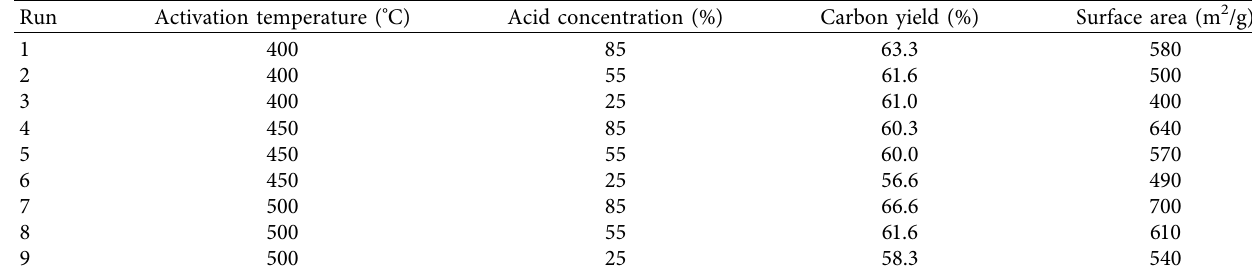
Table 3: Optimization of the preparation of activated carbon.